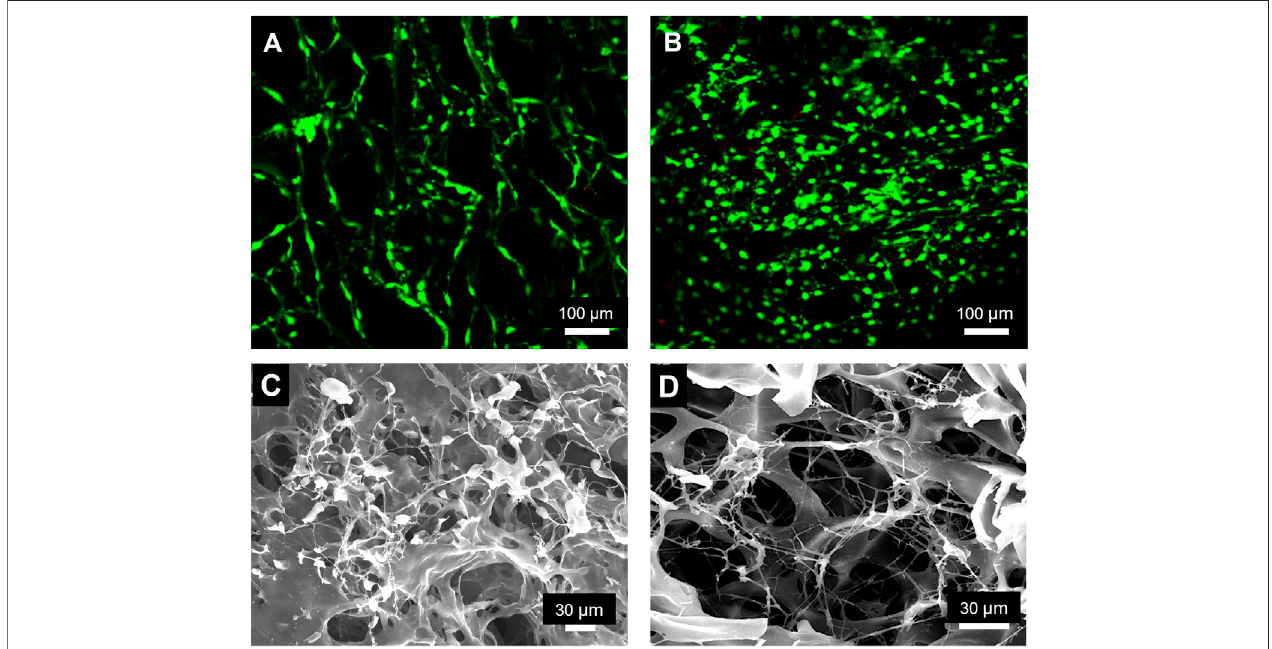
FIGURE4| Fibronectin coated collagenscaffoldssupportlong-term cell viability and matrix deposition by3T3-L1cells. Fluorescence micrograph ofaCol scaffold coated with Fn at 4 ° C after 48 h (A) and 7 days (B) of 3T3-L1 culture, showing very high cell viability. Live cells were stained with calcein (green) and dead cells with propidium iodide (red). SEM micrograph of a similar scaffold after 48 h of cell culture, indicating invasion of the scaffold by 3T3-L1s (C) . SEM image of a decellurarized scaffold, clearly showing an extended network of protein fi bers produced by 3T3-L1 cells during 48 h of culture (D) .